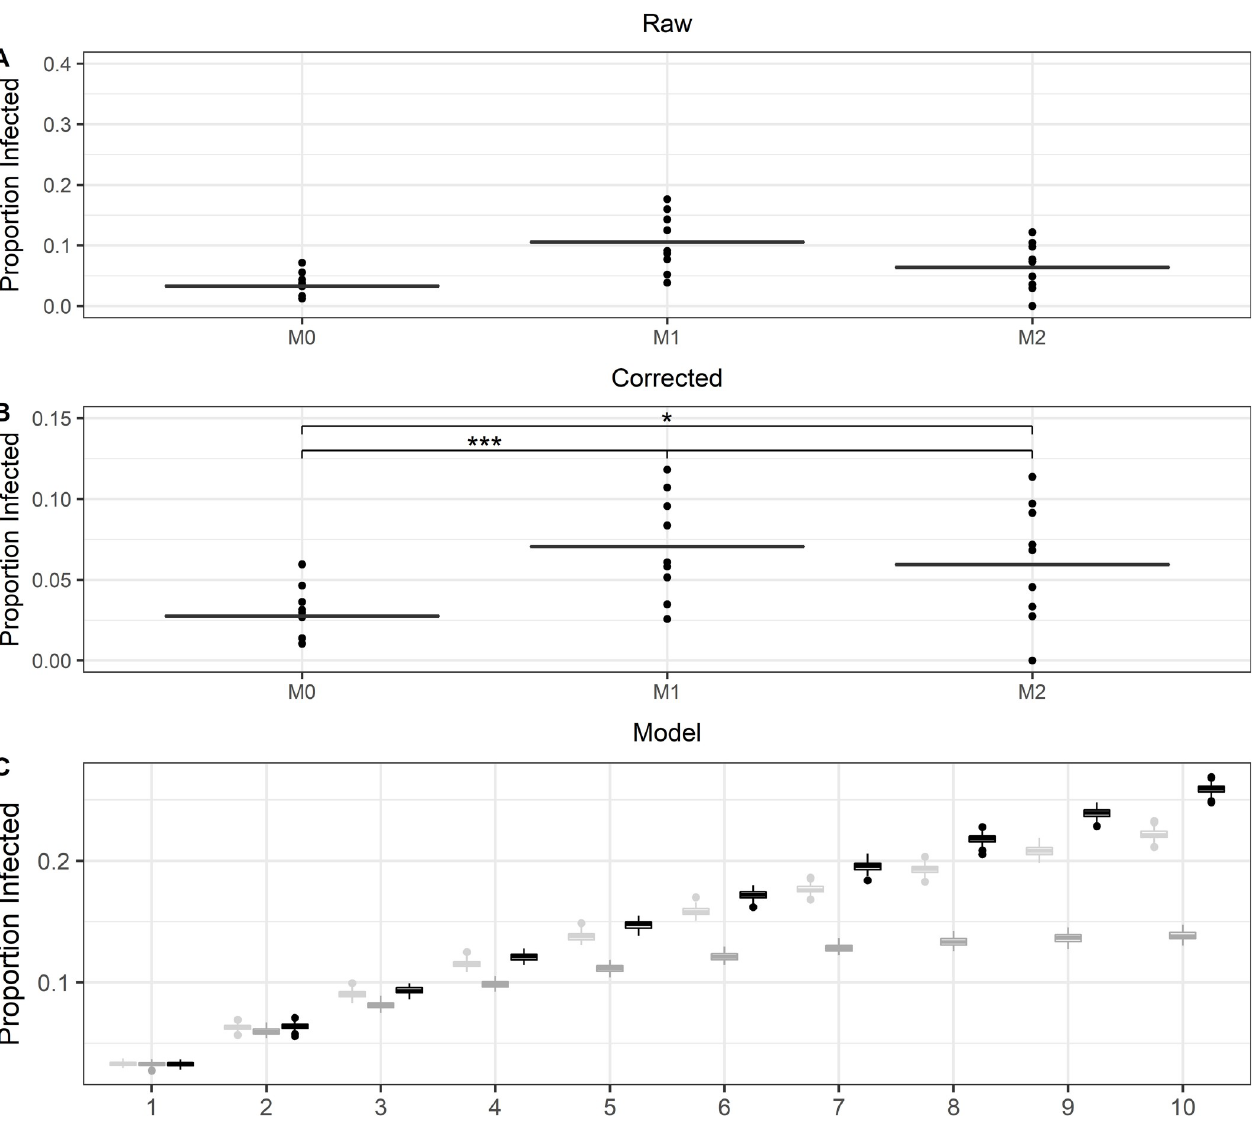
Fig 4. Comparisons of labelled macrophage populations and the proportion of which have ingested C . neoformans 24 hours post infection. A. The uncorrected proportion of adherent macrophages containing C . neoformans at the end of the infection. Data was collected from 10 independent experiments. B. The proportion of macrophages containing yeast after correcting for floating cells. Both the proportion of labelled cells compared to the original population of infected M1 macrophages as well as the frequency of labelled cells which ingested C . neoformans remained consistent throughout the time course. � , ��� signify P < 0.05 and 0.001 via ANOVA with Tukey multiple comparisons. C. A model depicting expected proportions of infected cells based only on random chance after sequential Dragotcytosis events for M0 (light gray), M1 (dark gray), and M2 (black) macrophages. Boxplots signify median with 95% confidence interval